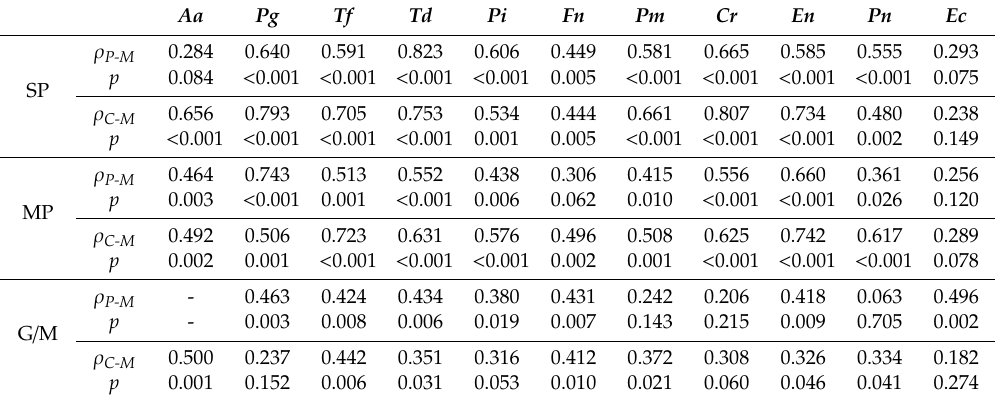
Table 5. Correlations between di ff erent sampling methods for the detection of each bacterial species in di ff erent study groups. Mouthwash samples (M) were correlated with paperpoint samples (P) and gingival retraction cord samples